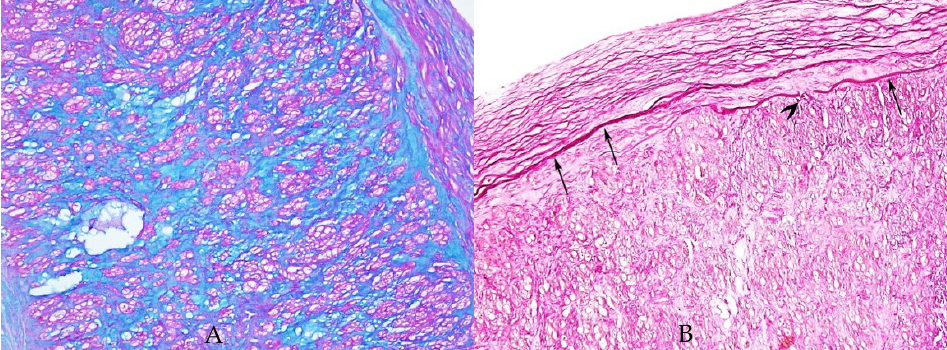
Figure 1. Haematoxylin-eosin coloration. ( A ) High-power view of the artery with medial calcification and myxoid degeneration. HE, × 400. ( B ) High-power view of the medial myxoid degeneration. Notice the cystic spaces which encounter external elastic lamina (arrow); HE, × 400.